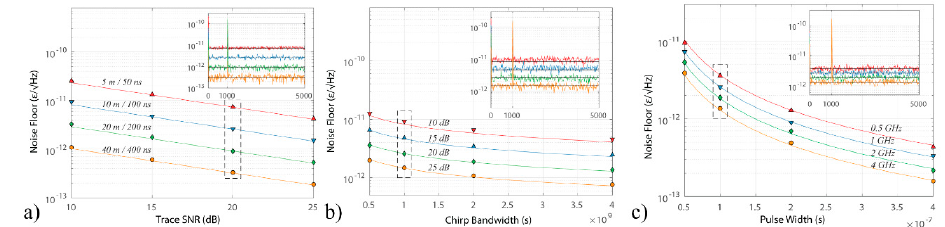
Figure 11. (From [12]) ASD strain noise floors of simulated data and for varying parameters of Equation (12). ( a ) Noise floor as a function of trace SNR electrical and τ p . ( b ) Noise floor as a function of τ p and δυ p . ( c ) Noise floor as a function of δυ p and trace SNR electrical , @ 2018 IEEE [12]. Experimentally, reaching the theoretical limit of Equation (12) turns out to be a feasible task.